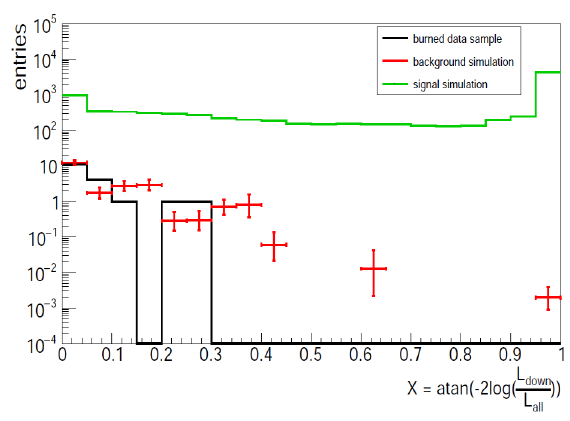
Figure 9. Distribution of the X variable (see text for details) for the events from 10% of data (black), background simulations (red), signal simulations (green)